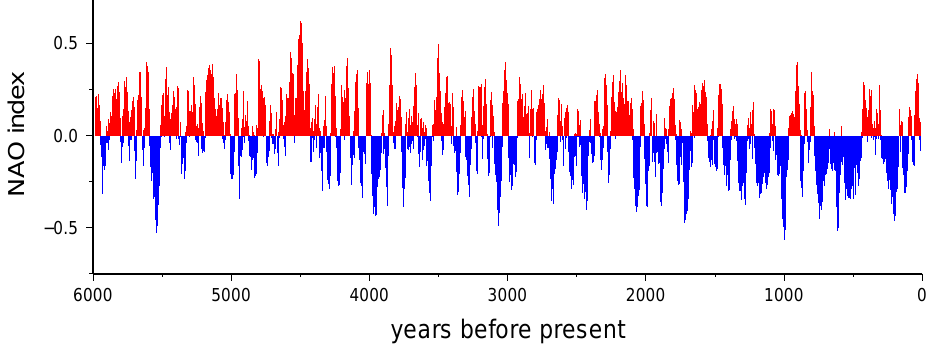
Fig. 8. Time-series of North Atlantic Oscillation index calculated from the first EOF of winter mean sea level pressure over the North Atlantic region (30-year running mean).